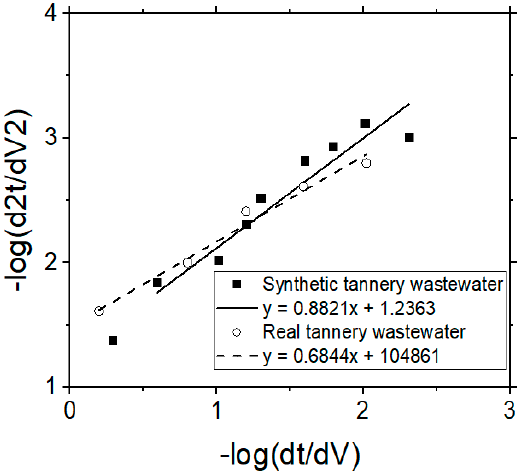
Figure 11. Presentation of the experimental data following the Hermia’s model in order to find the (major) mechanism of membrane fouling during the application of VSEP for the treatment of simulated or real industrial